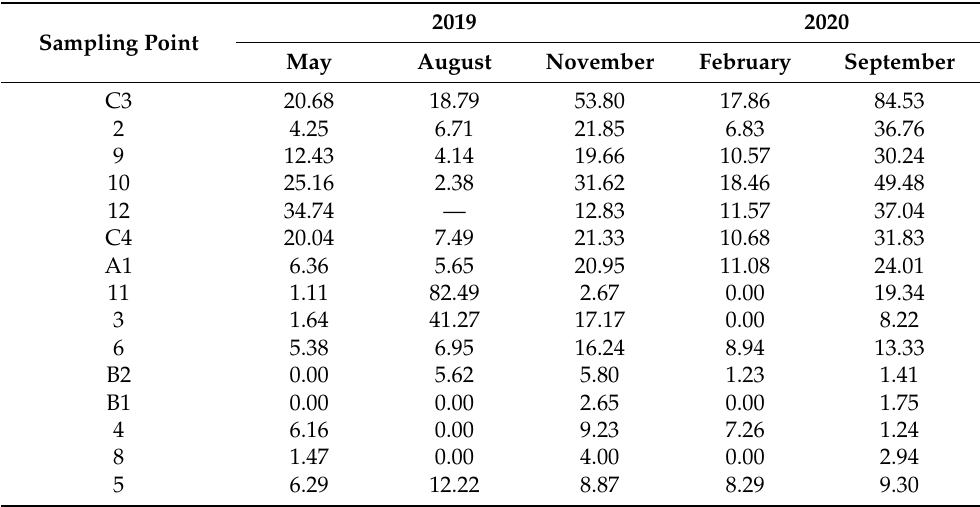
Table 4. Risk quotients for negligible concentrations (RQ NCs ) of total PAHs ( Σ 14 PAHs). RQ NCs sorted by sampling point and sampling